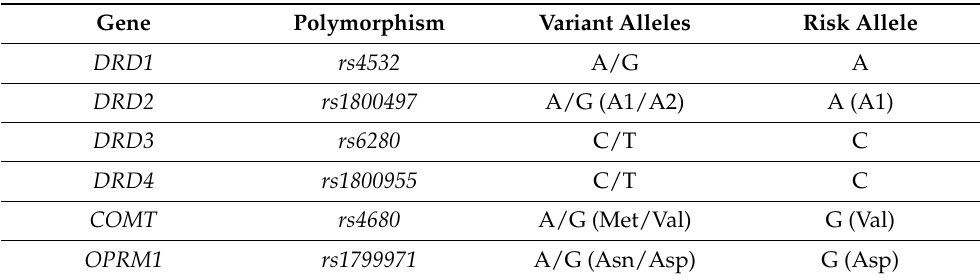
Table 2. Single nucleotide polymorphisms (SNPs) *. Gene Polymorphism Variant Alleles Risk Allele DRD1